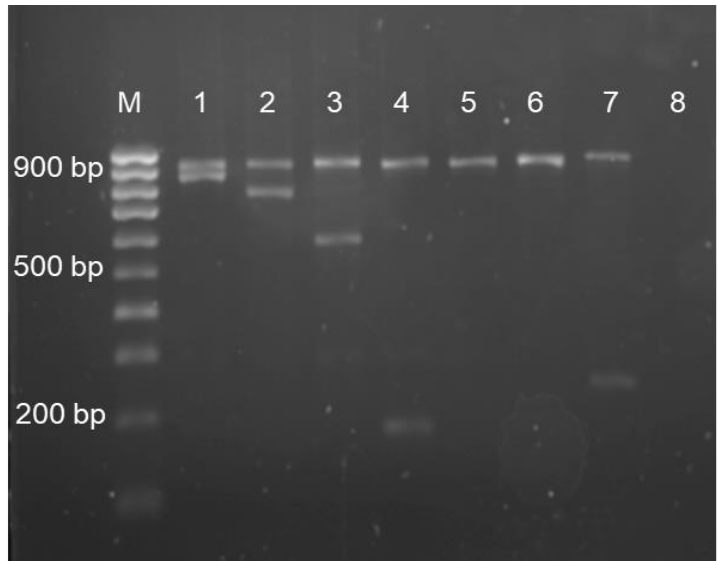
Figure 2. Representative gel image for α nondeletional mutations: Lane M: 100 bp ladder; Lane 1: Figure 2: Representative gel image for α nondeletional mutations : Lane M: 100 bp ladder; Lane 1: initiation codon mutation; Lane 2: codon 30 mutation; Lane 3: codon 59 mutation (Hb Adana); Lane